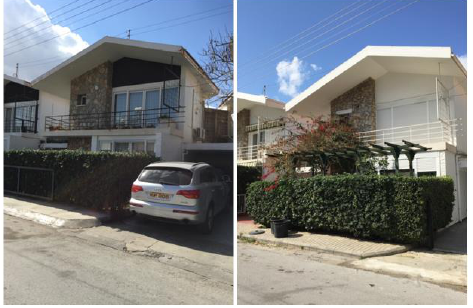
Figure 14. Plan of Ground and first floor (Developed by Author). There are three different plans for ‘Efruz’ Houses but all the types have courtyards (forecourt and backyard) of houses. Those backyards and forecourts can be associated to the patio in vernacular architecture, which is one of the main resources to Mediterranean modernist in architecture. See figure ‘16’.